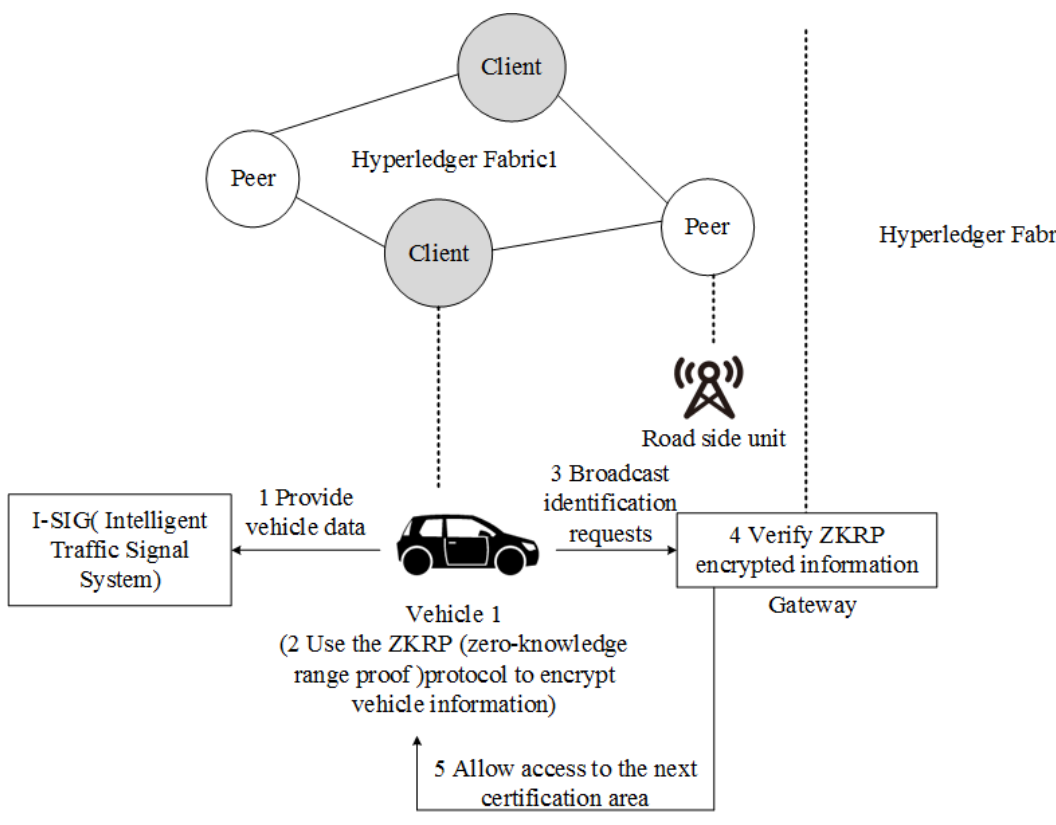
Figure 34. Reconstruction diagram of reference [66].